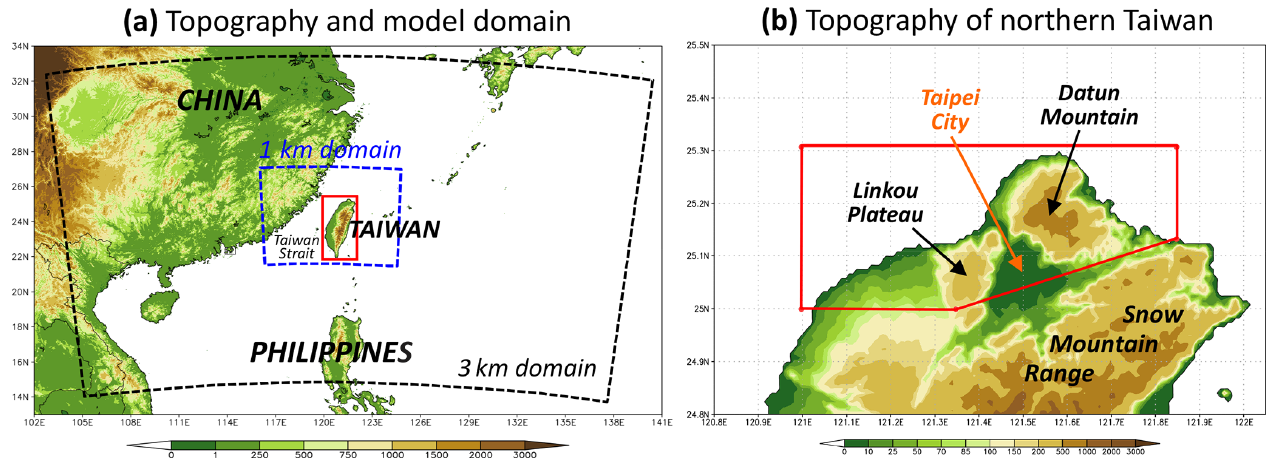
Figure 1. (a) The topography of Taiwan and surrounding areas (m, color, scale at bottom) and the domains of 3 and 1km Cloud-Resolving Storm Simulator (CReSS) experiments. The red box depicts the region of terrain removal in the F3-NT and F1-NT experiments. (b) Topog- raphy (m) and the region of terrain removal in northern Taiwan used in the F3-NNT and F1-NNT experiments (pentagon enclosed by red lines). See Sect. 2.3 for the meanings of experiments.